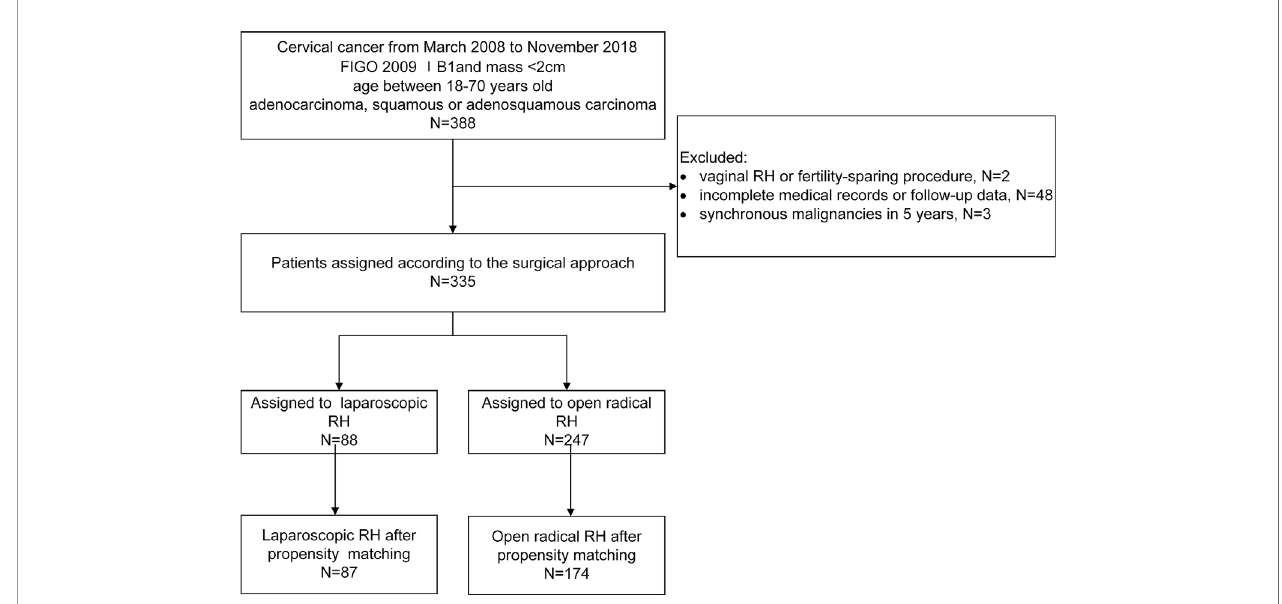
FIGURE 1 | Flow diagram of recruitment and